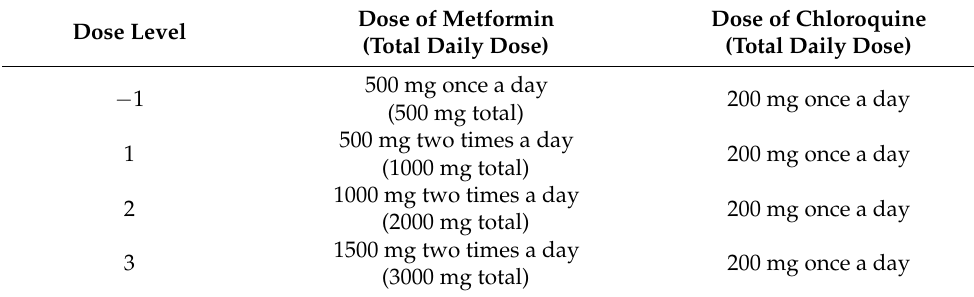
Table 1. Dose-escalation schedule for metformin and chloroquine. Dose